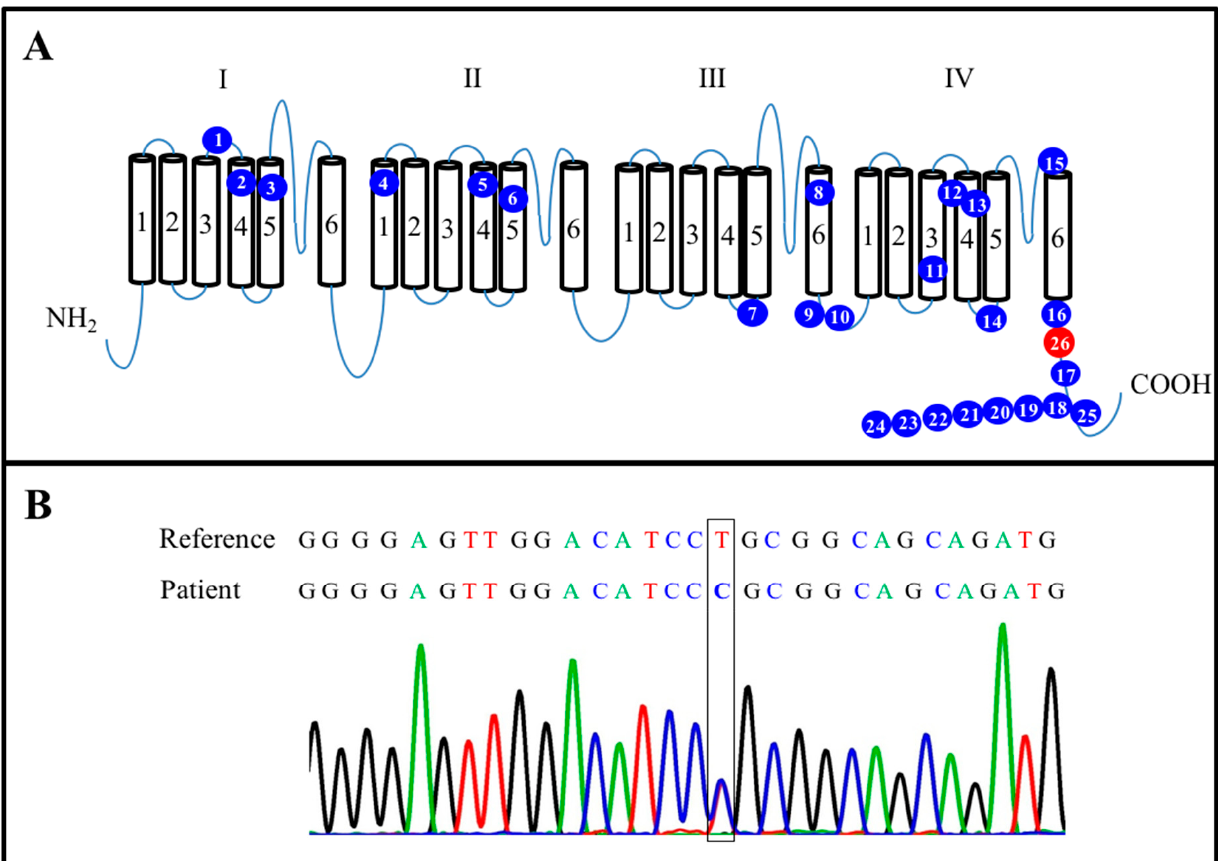
Figure 1. Characterization of mutated SCN8A. ( A ) Summary of 26 novel mutations in the SCN8A protein. The blue spots represent 25 mutated points identified in previously published research. The red spot is located at L1865P (c.5594T > C) position. ( B ) Sanger sequencing confirmed an SCN8A (c.5594T > C) mutation in the present case.